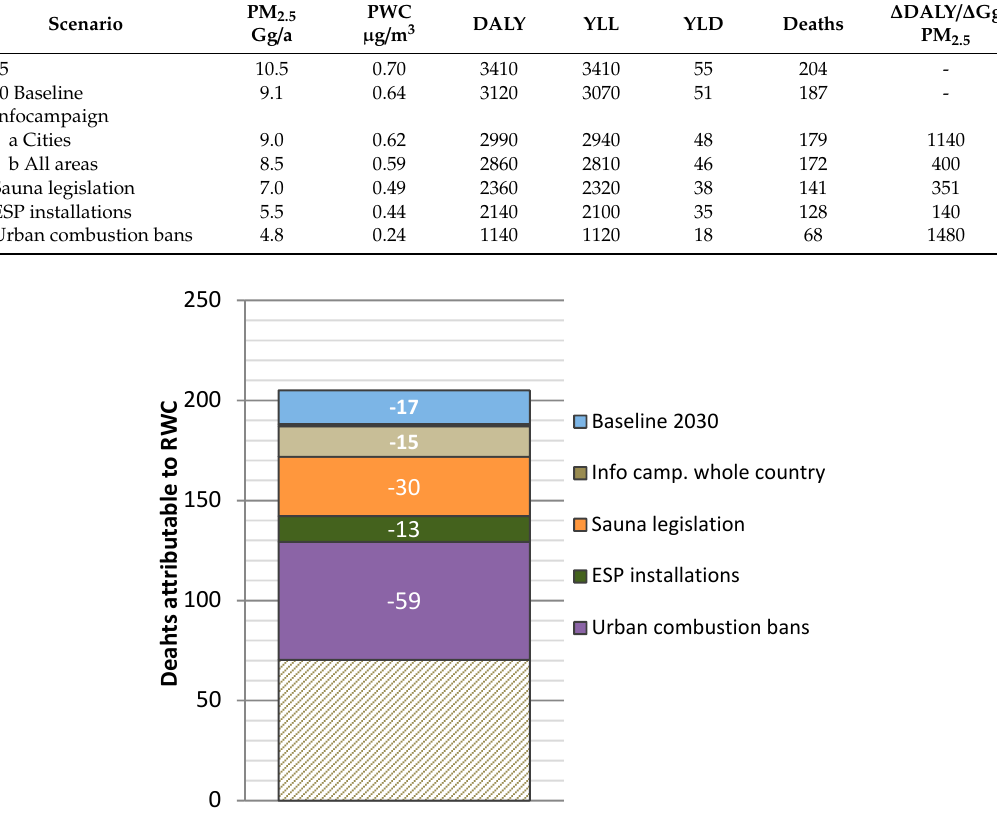
Table 3. Estimates for disease burden attributable to RWC in the studied scenarios. The scenarios have been evaluated with respect to Baseline in 2030. The scenarios are cumulative, i.e., they also include the measures defined in the previous scenarios. The notations: DALY = disability adjusted life years, YLL = years of life lost, YLD = years lived with disability, Δ DALY/ Δ Gg PM 2.5 = changes